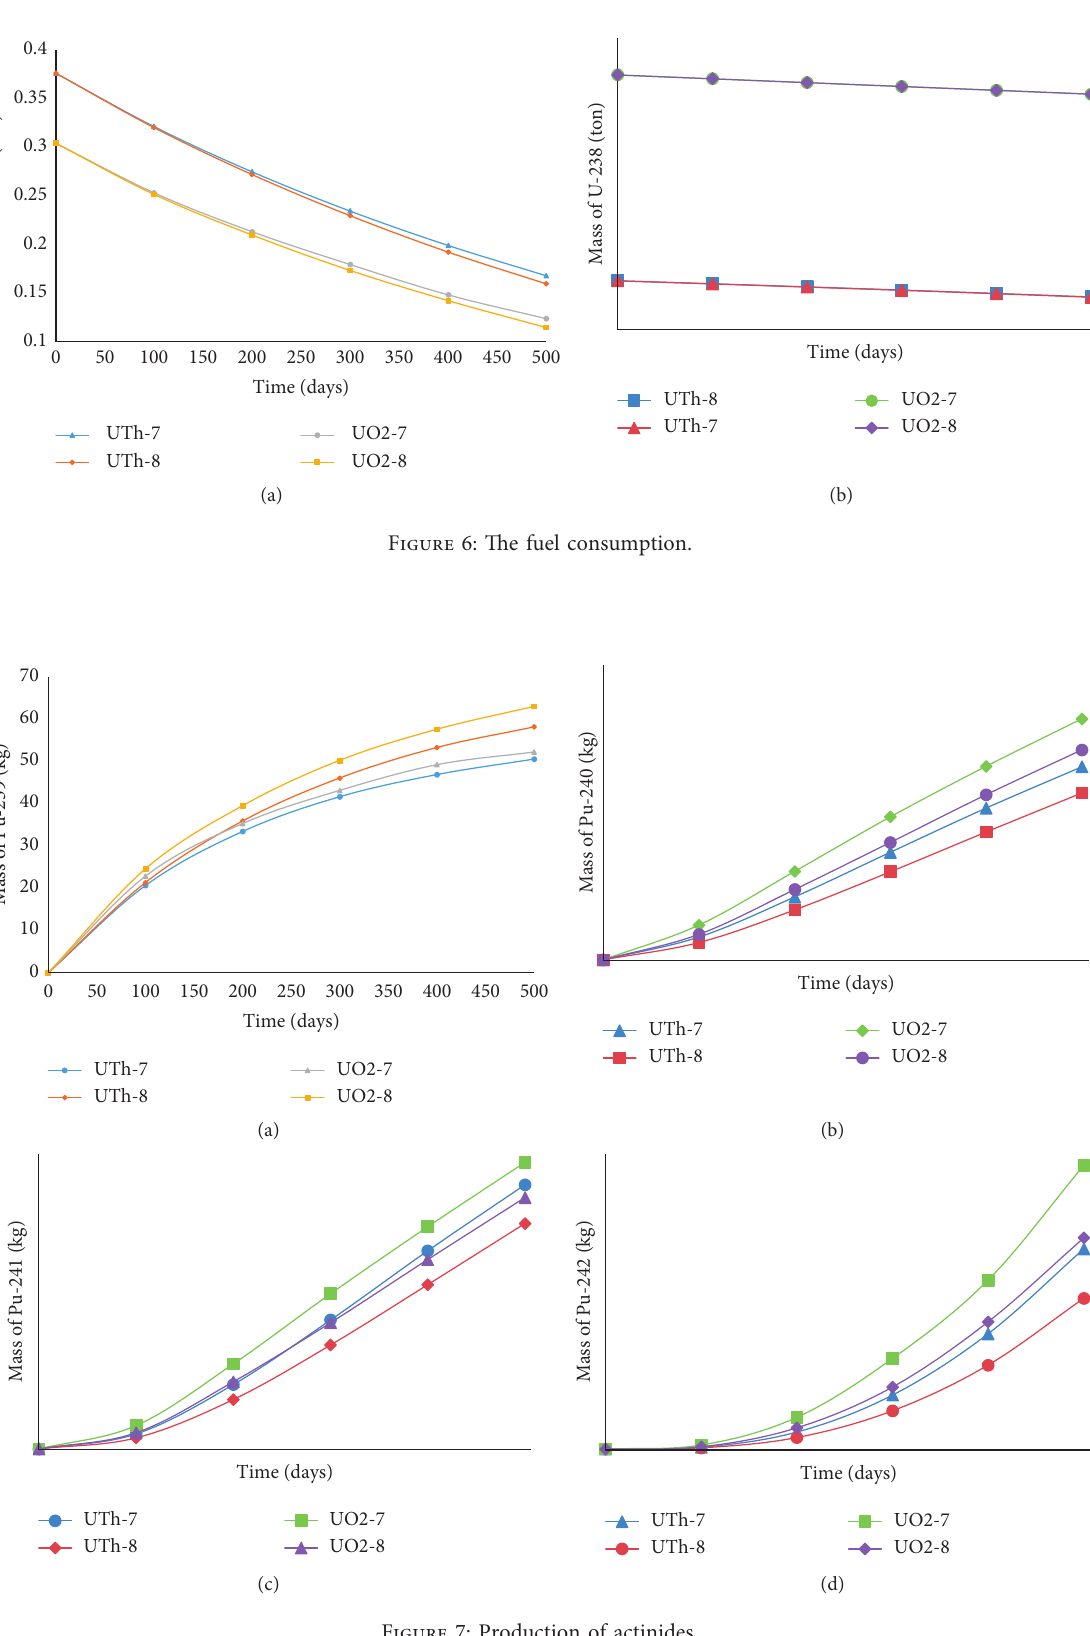
Figure 7: Production of